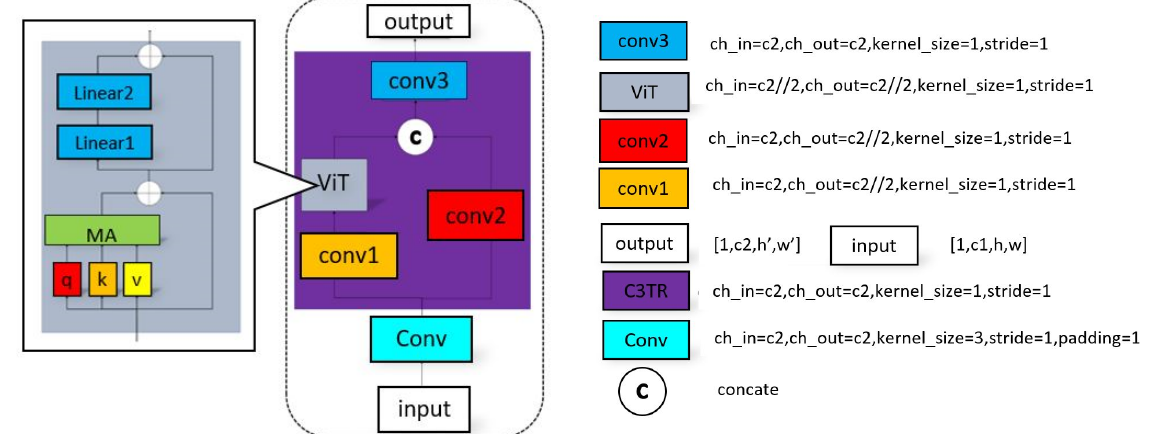
Figure 10. Proposed feature extraction network based on CNN-ViT fusion.